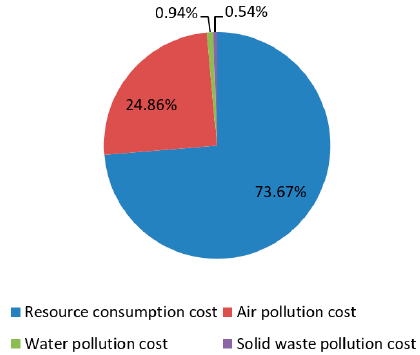
Figure 4. Life Cycle socio-economic investment.